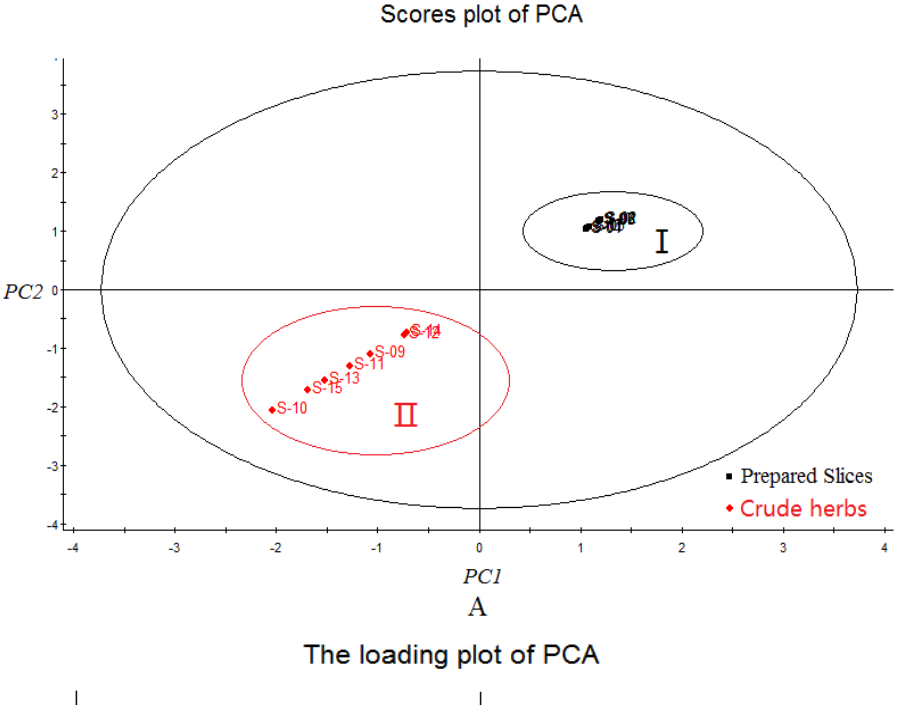
Figure 5. Score plot of principal component analysis (PCA) ( A ) and PCA loading plot ( B ) of Radix Isatidis